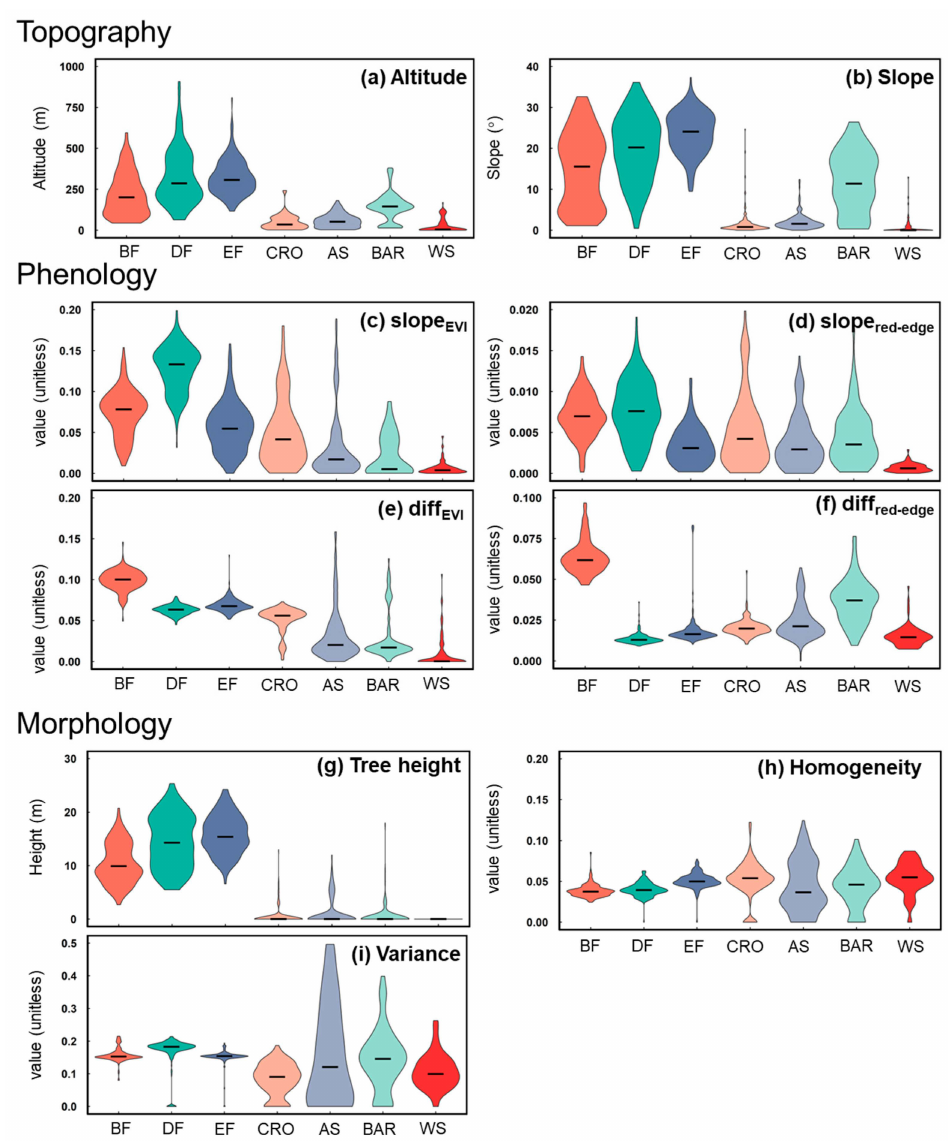
Figure 5. Static patterns for different categories. The width of each violin represents the relative density at different values. The black line is the median of each category;( a , b ) display the topography patterns; ( c – f ) display the phenology patterns; ( g – i ) display morphological patterns. BF = bamboo forest, DF = deciduous forest, EF = evergreen woody forest, CRO = cropland, AS = artificial surface, BAR = barren, WS = water surface. Different colour represents different